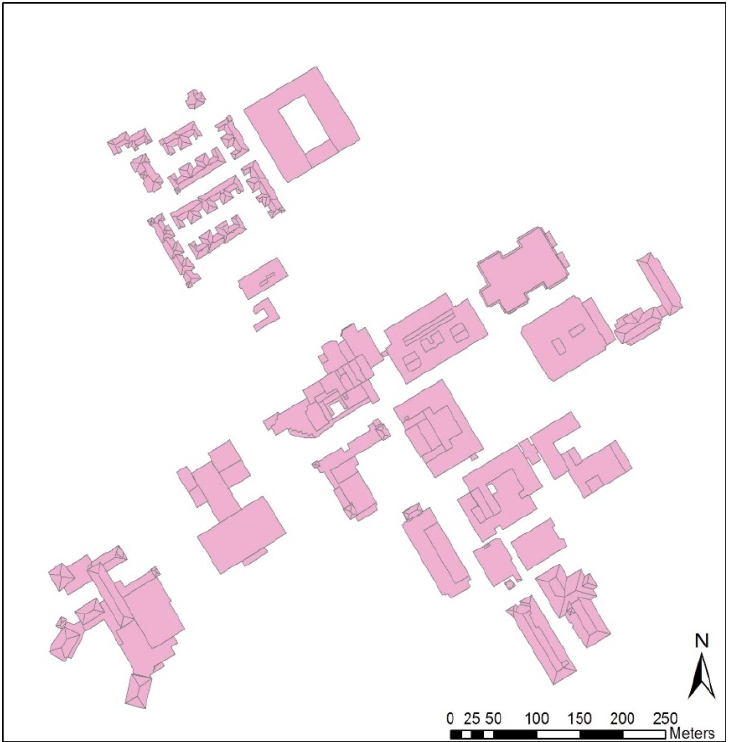
Figure 2. Building footprints of University of Texas San Antonio (UTSA) campus generated using ENVI LiDAR extension.